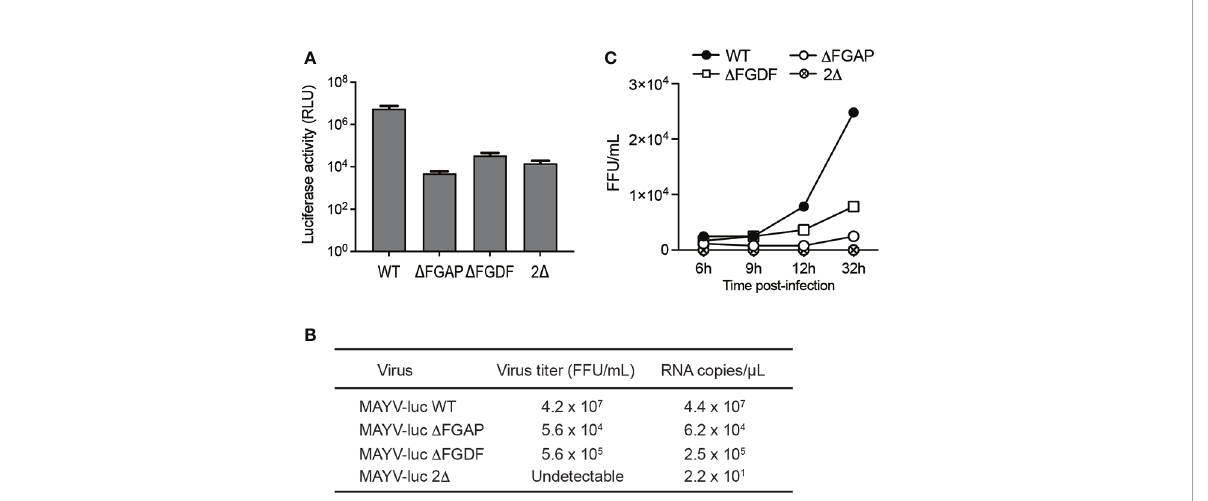
FIGURE 9 Contribution of FGAP and FGDF motifs to MAYV replication. (A) HEK293T cells were transfected with WT, D FGAP, D FDF, or 2 D MAYV infectious clones. At 24 h post-transfection, plasmid expression was controlled by determination of luciferase activity in the cell lysates. Data are averages of two experiments, and error bars are standard deviations. (B) Genome equivalent in supernatants was quanti fi ed by RT-qPCR, and infectious titers were determined in parallel. (C) Multiple step growth curves were determined on HeLa cells infected at a MOI of 0.01. At 6, 9, 24, and 32 h postinfection, supernatants were collected, and viral titers were